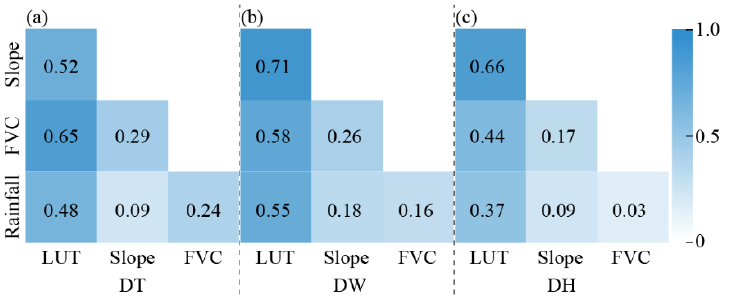
Figure 7. Effect of interactive impact on water erosion: ( a ) dry–temperate valley (DT), ( b ) dry–warm valley (DW), and ( c ) dry–hot valley (DH).